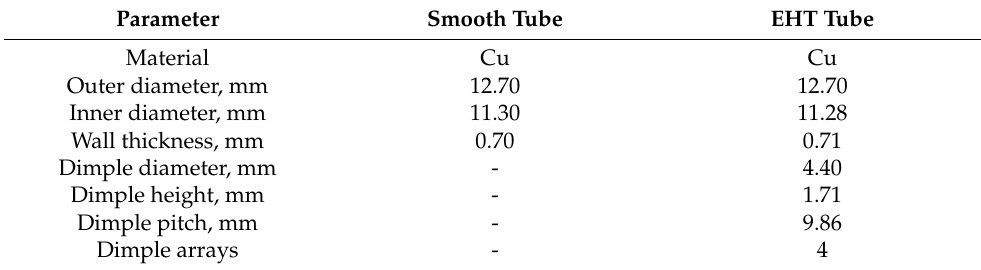
Figure 6. Systematic diagram of the apparatus for testing condensation flow in tubes [13]: ( A ) test apparatus, ( B ) test section, ( C ) EHT tube, ( D ) front view, ( E ) rear view, ( F ) repeated tests of the EHT tube. Table 1. Geometric parameters of smooth and EHT tubes.